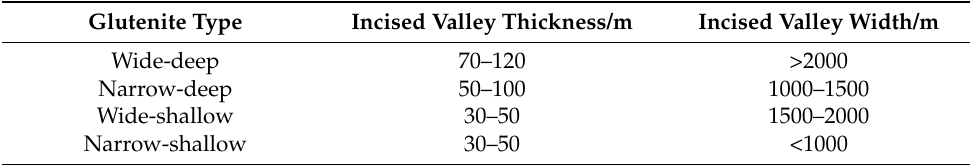
Table 2. Standards for classification of incised valley types.